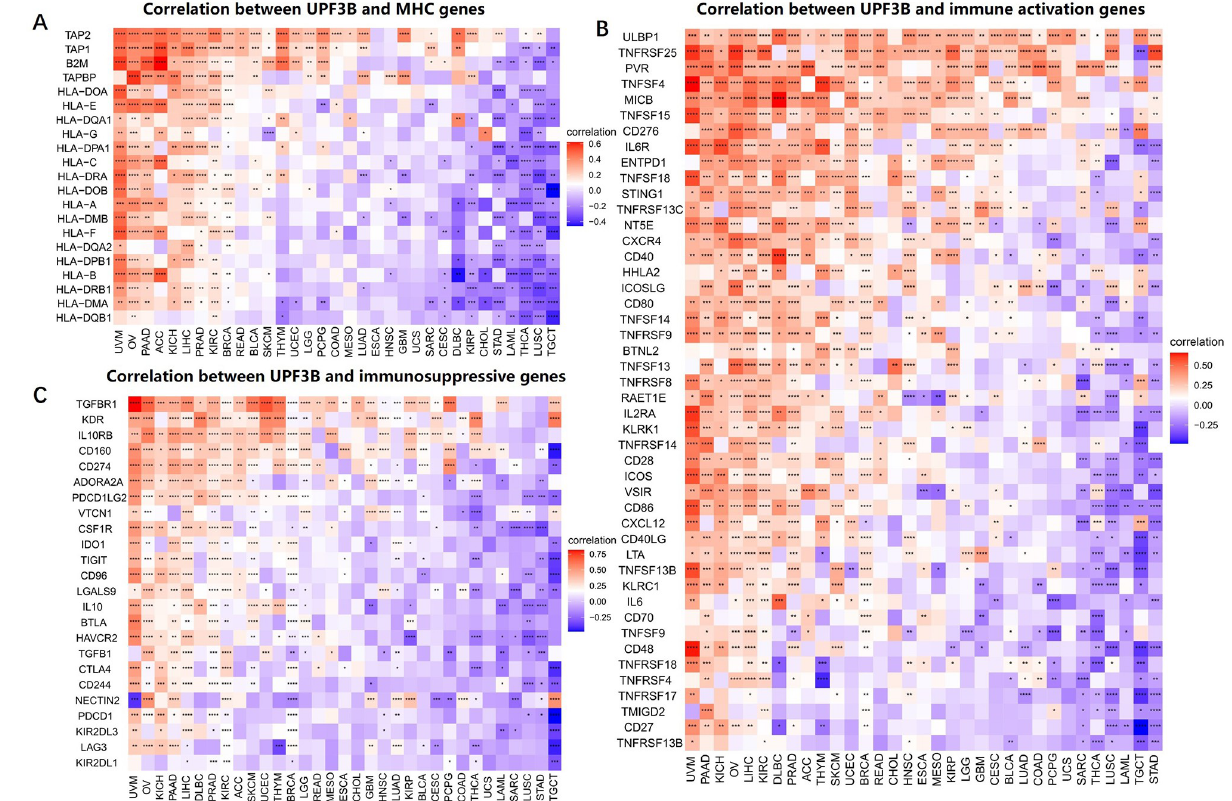
Fig 8. Co-expression of UPF3B and immune-related genes. (A) Correlation between UPF3B mRNA expression and MHC molecules. (B) Correlation between UPF3B mRNA expression and immune activation genes. (C) Correlation between UPF3B mRNA expression and immunosuppressive genes. � p < 0.05, �� p < 0.01, ��� p < 0.001, ���� p < 0.0001.